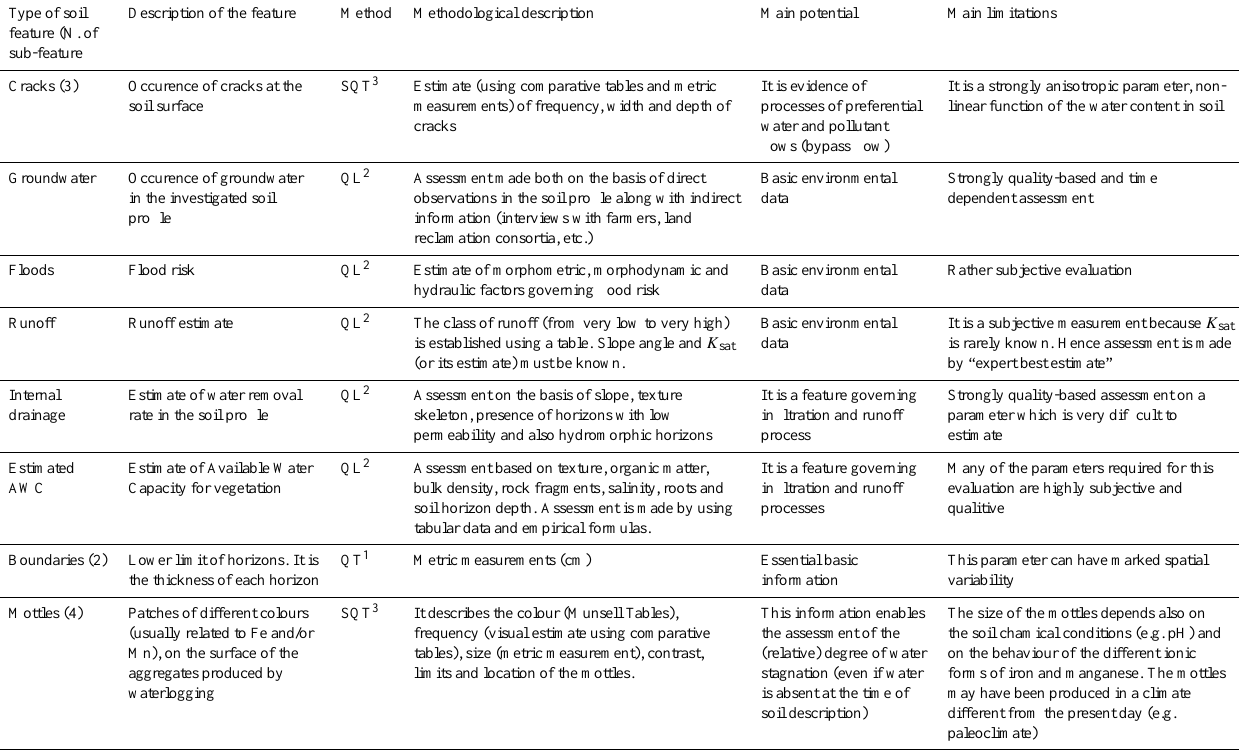
Table 3a. Types of data of great (and direct) hydrological interest contained in soil map